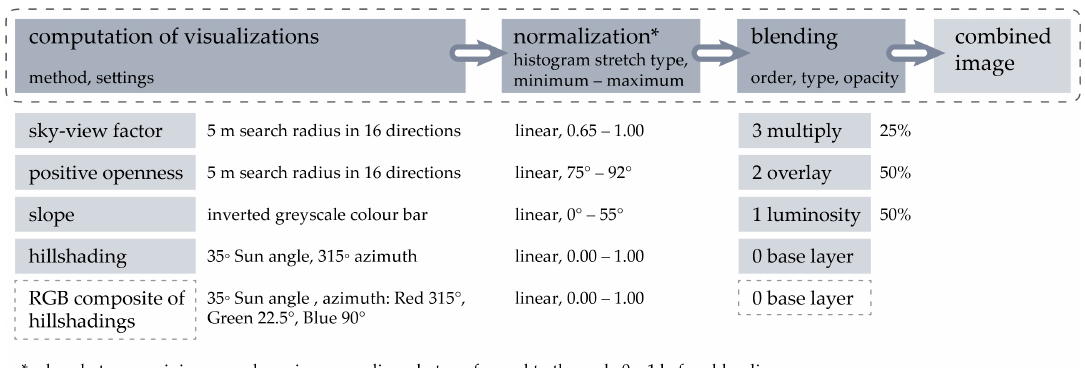
Figure 1. A schematic workflow illustrating the steps, variables, and their settings in producing the visualization for archaeological topography. Either hillshading or an RGB composite of hillshadings from three directions can be used as a base layer. Figure 6 illustrates the results of the blending